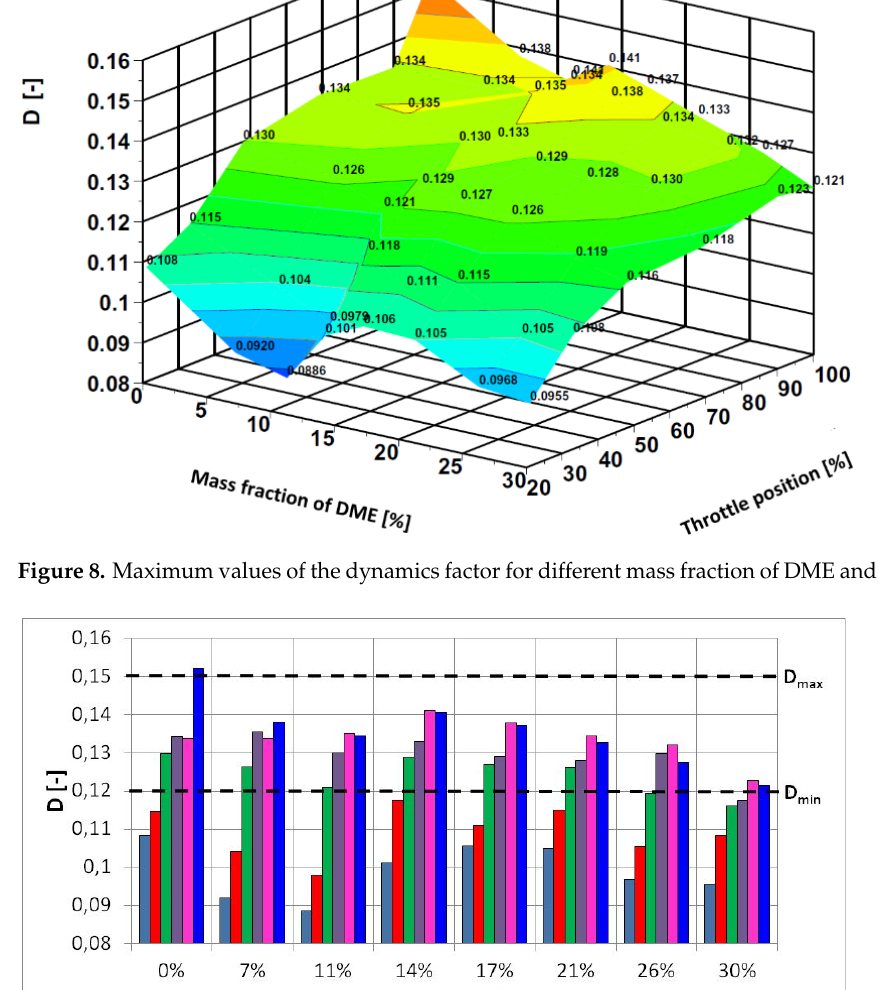
Figure 9. Maximum values of the dynamics factor for different mass fraction of DME and engine load.